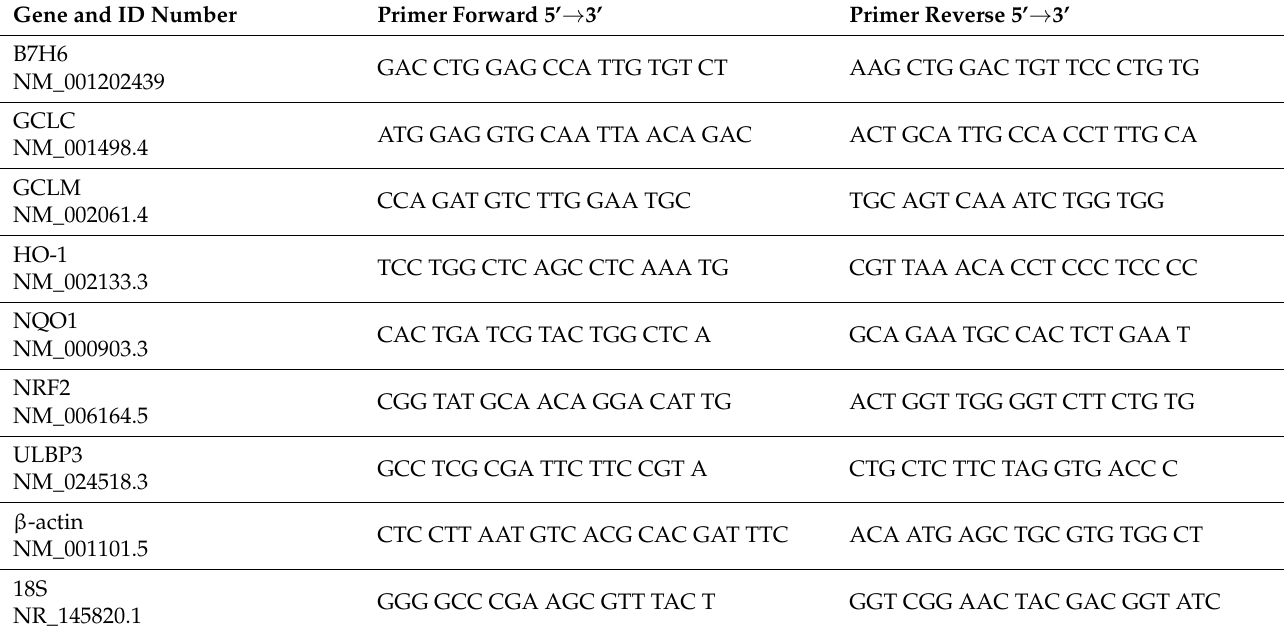
Table 1. Primers used for PCR and